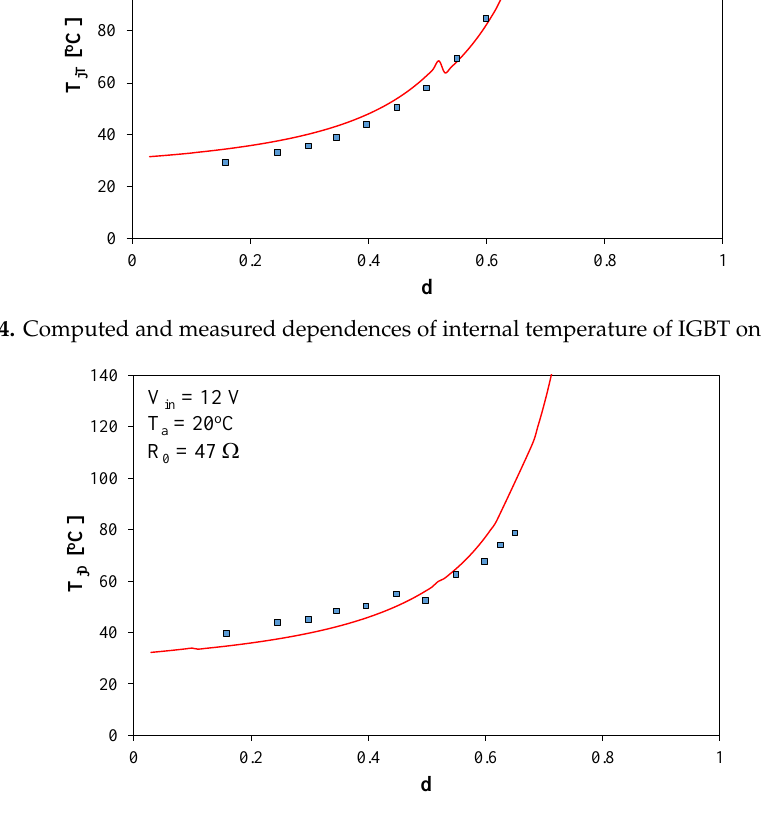
Figure 15. Computed and measured dependences of internal temperature of the diode on duty cycle.